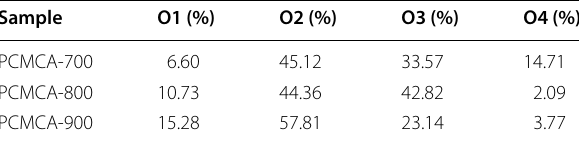
Table 3 XPS data of O 1 s composition of PCM-derived